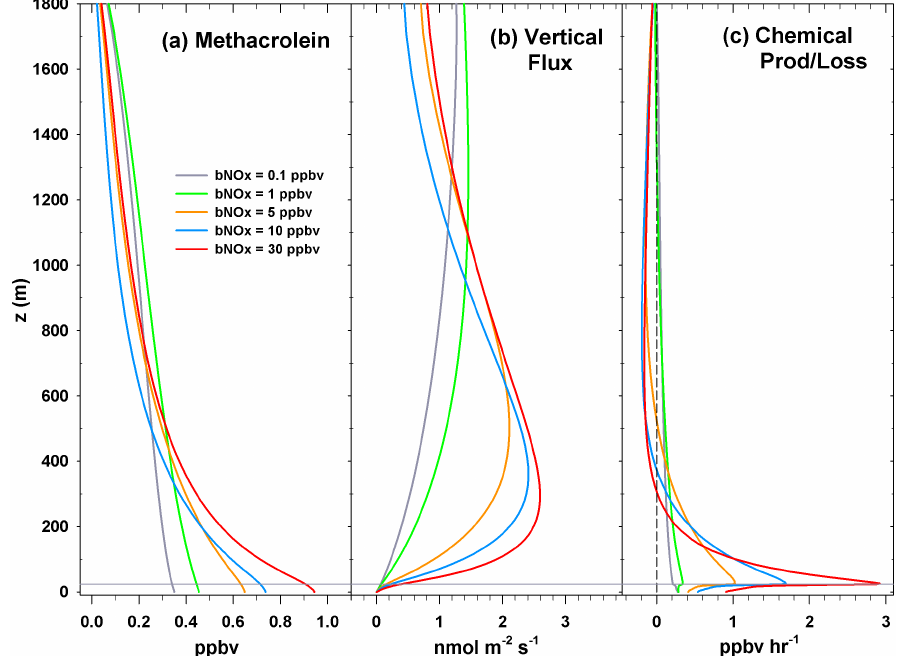
Fig. 9. Vertical profiles of methacrolein (a) mixing ratio (ppbv), (b) vertical flux (nmolm − 2 s − 1 ) , and (c) chemical production or loss (ppbvh − 1 ) for each background NO x value (horizontal gray line is canopy top height).